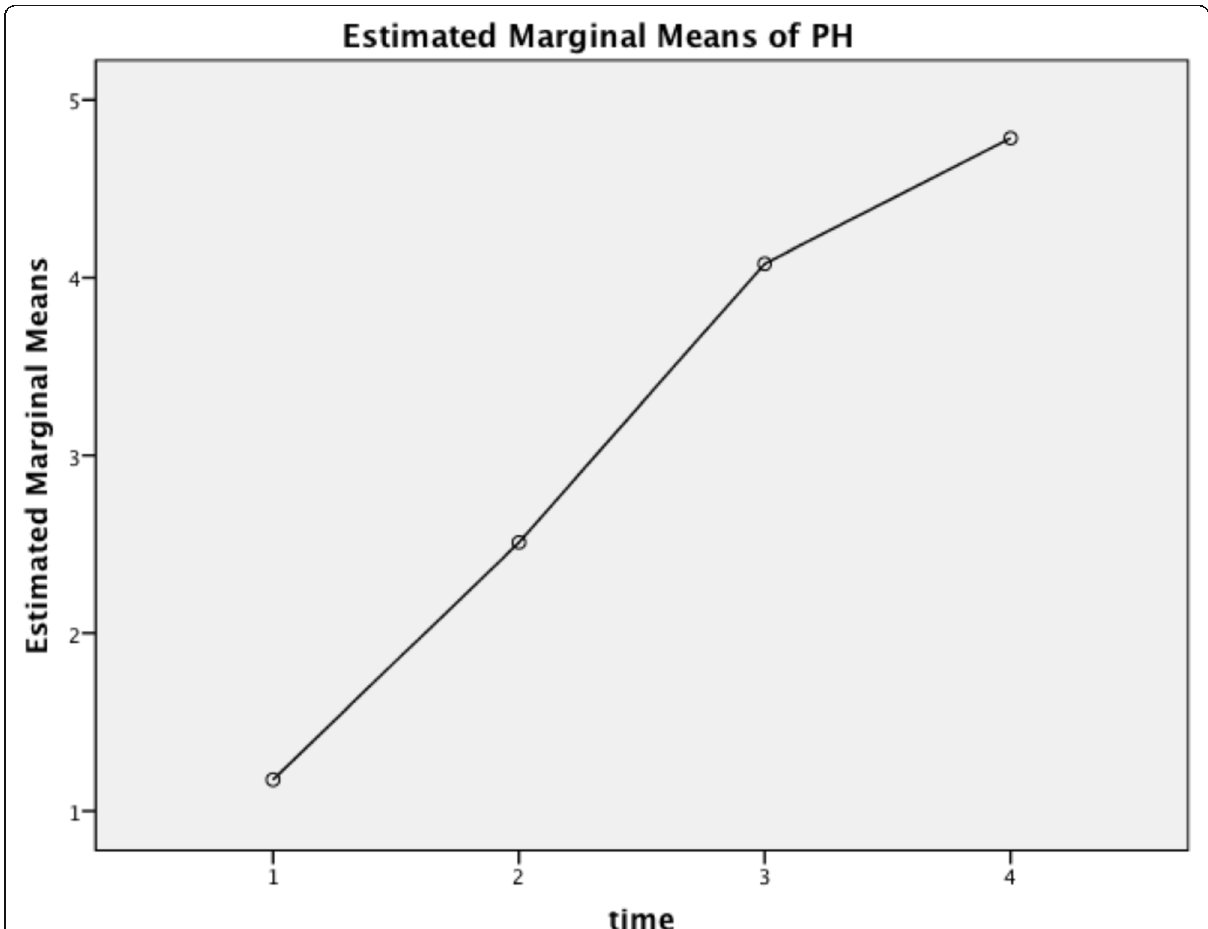
Fig. 7 Student pH scientific ideas across an evolving explanation ( n =